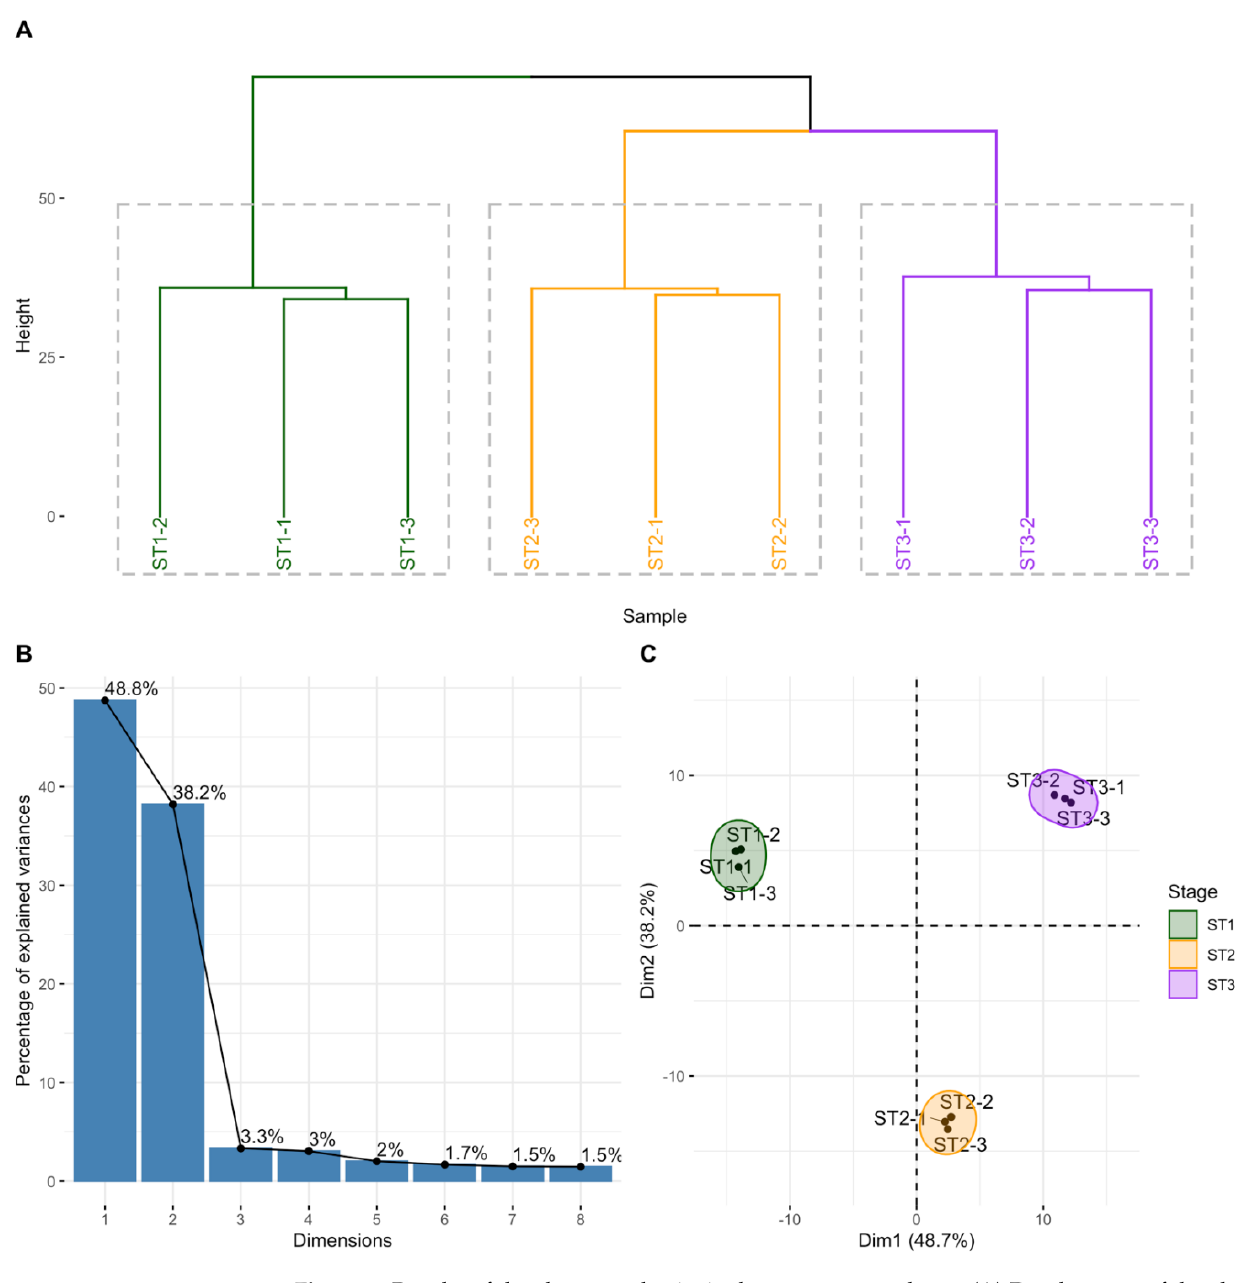
Figure 1. Results of the cluster and principal component analyses. ( A ) Dendrogram of the cluster analysis solution; ( B ) Screen plot of the percentage of sample expression variability explained by the principal components/dimensions identified in the principal component analysis (PCA); ( C ) Graph of samples scores in the first two dimensions/principal components of the PCA analysis. The figures are colored in the replicas according to the three levels that make up the stages of thymocyte maturation (ST1-3).